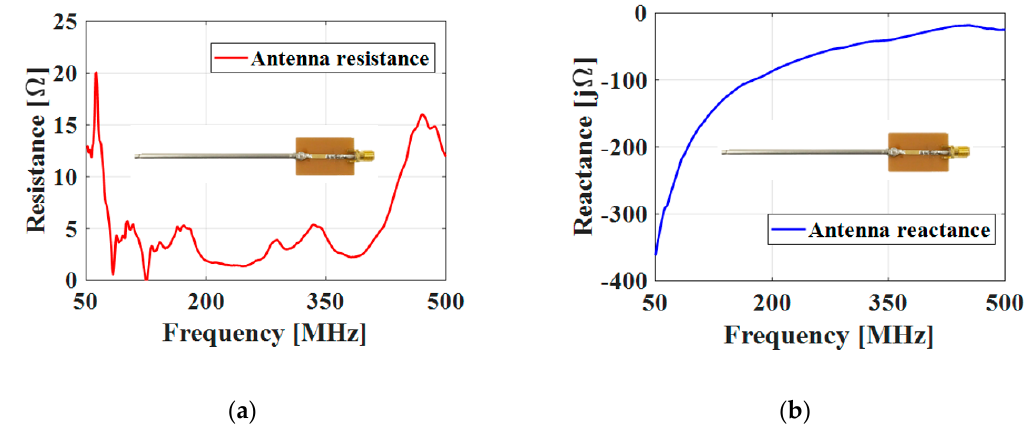
Figure 2. The impedance of a short monopole antenna as a load: ( a ) resistance and ( b )